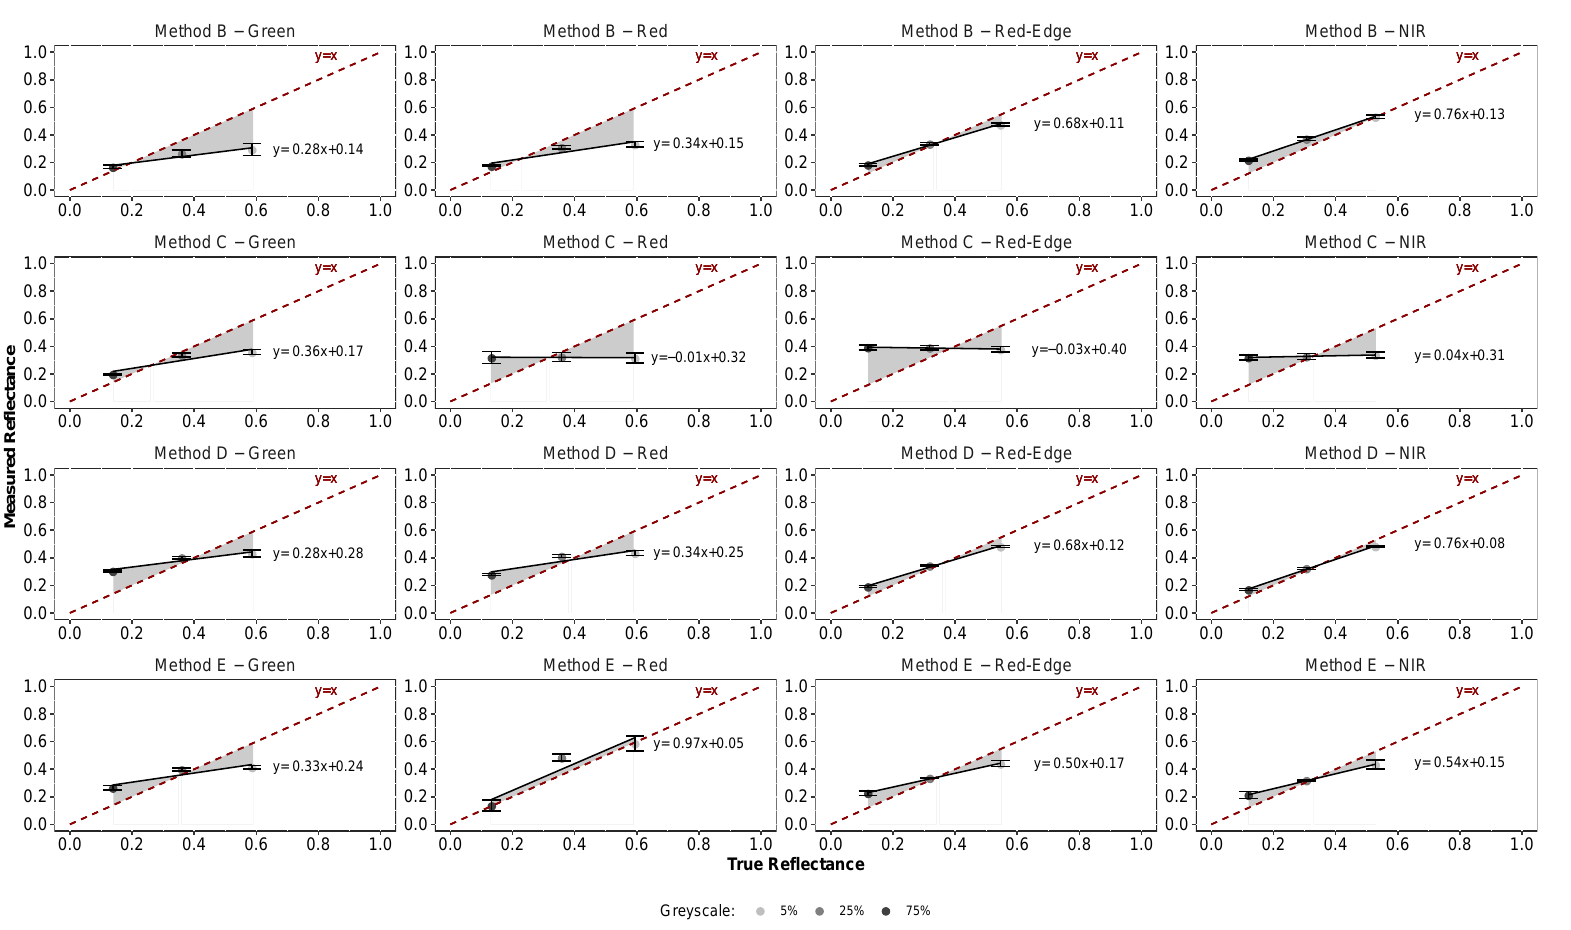
Figure 8. Relationships between validation targets measured and true reflectance values for each multispectral band and radiometric calibration method. Measured reflectance values were calculated as the mean validation targets measured reflectance across flights. Confidence intervals around the measured reflectance values indicated the standard error of the mean measured reflectance between flights. Radiometric error corresponded to the difference between true and measured reflectance values and was represented in grey within individual